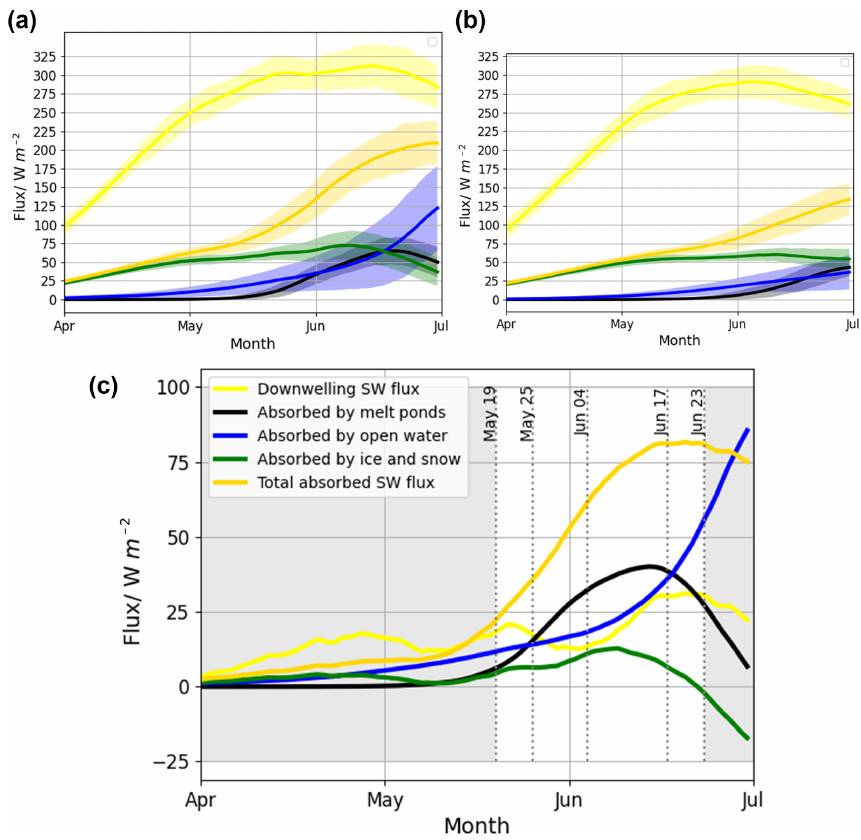
Figure 11. Incident surface short-wave (SW) flux absorbed by each surface type. Calculated on ice-covered grid cells. (a) The LIG simulation (b) the PI simulation (c) anomaly of the LIG from the PI simulation. Figures show quantities calculated from the mean daily downwelling (yellow) and total absorbed (gold) SW flux at the surface, as well as the approximate breakdown of SW flux absorbed by open water (blue), exposed ice and snow (green), and melt ponds (black), all computed from daily model output from the first 50 years from each of the PI and LIG simulations. Further details in Sect.